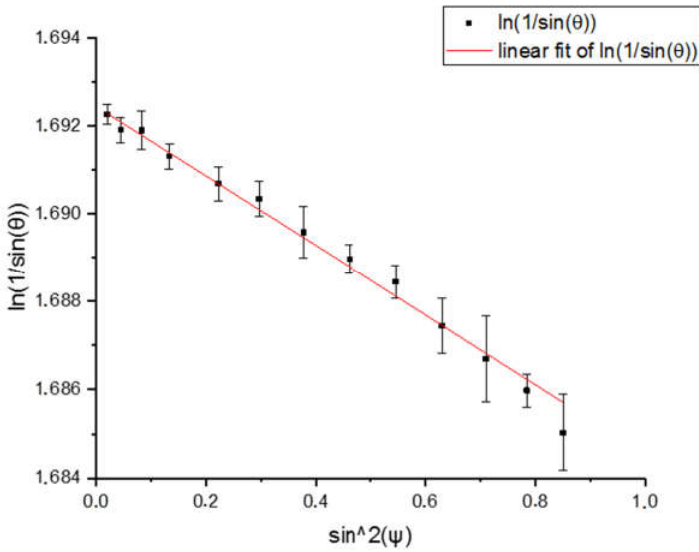
(cid:16) (cid:17)  versus sin  ψ for the oxide peak (116). Figure 10. ln 1 versus sin 2 ψ for the oxide peak  sin θ